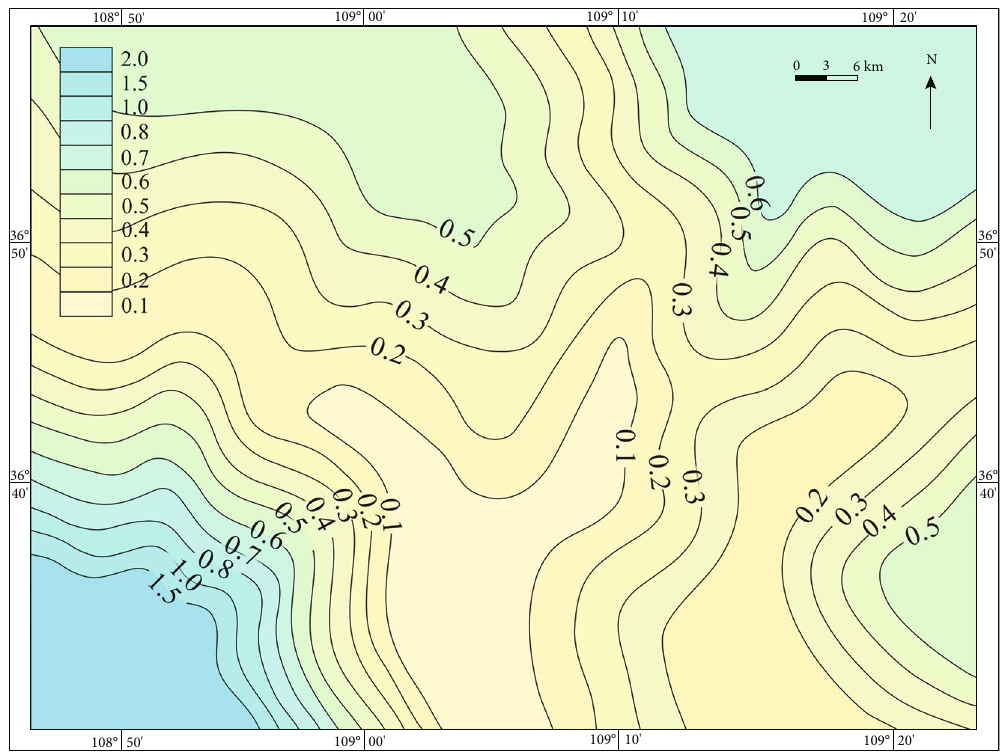
Figure 6: Distribution map of Na + /Cl − ratios; the contour line represents speci fi c numerical